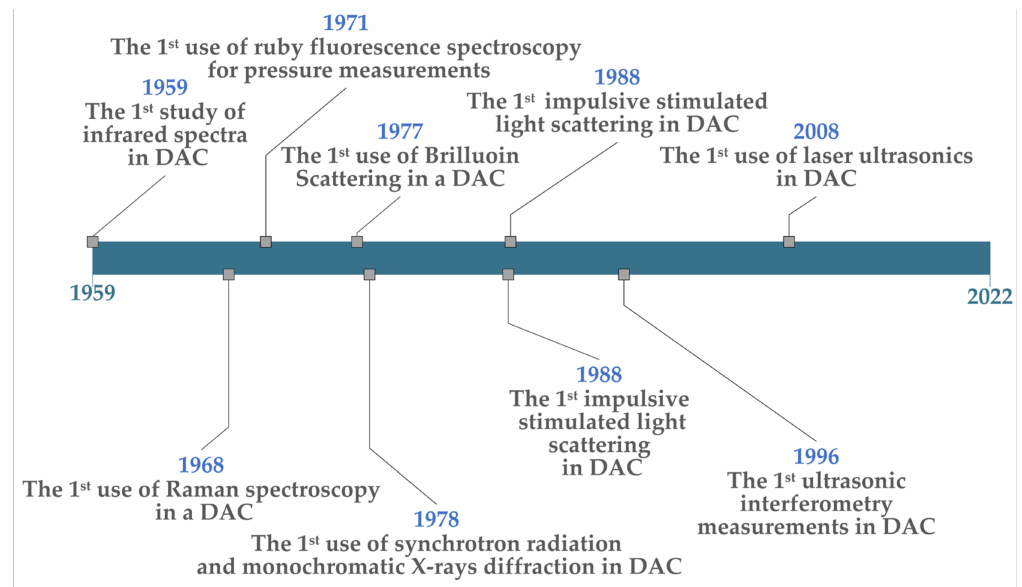
Figure 10. Chronology of Important LC-DAC